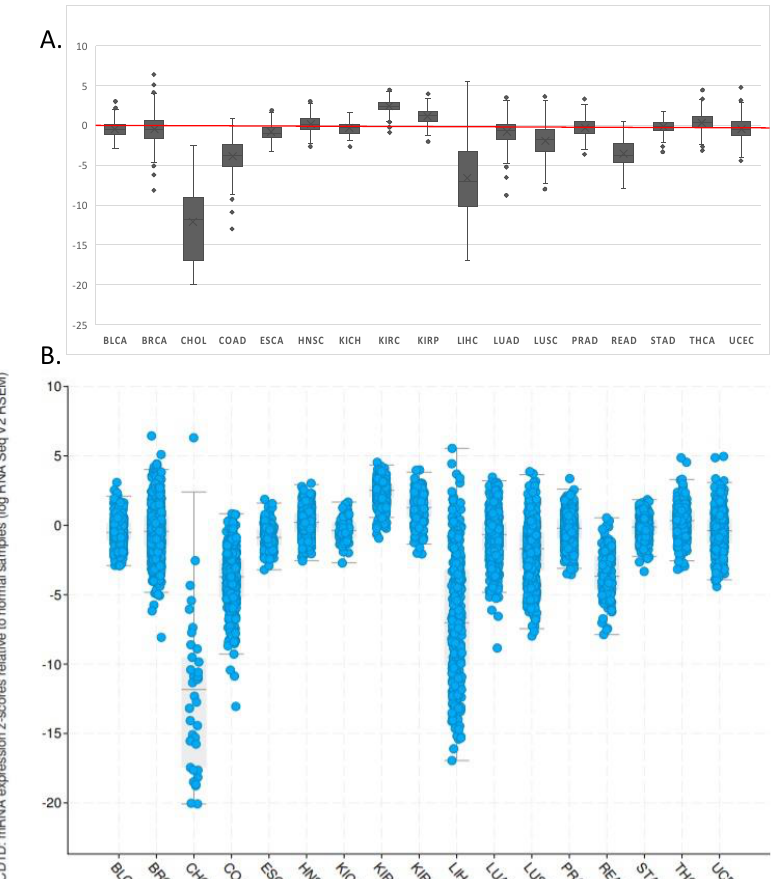
Figure 1. CD1D expression in different cancer types compared to corresponding healthy tissues. NKT cells can recognize and mediate cytolysis, thus CD1d-expression on malignant cells is an area of active investigation. It is thought that higher expression of CD1d leads to in higher tumor cell killing. Thus, several tumors have been shown to downregulate CD1d expression, perhaps in order to escape NKT cell-mediated immunosurveillance, or these data reflect a positive selection pressure for CD1d-low tumor cells. cBioPortal was used to investigate CD1D expression in different cancer types available in the TCGA database [64]. Data shown represents CD1d mRNA expression z scores relative to normal samples. ( A ) Median levels of CD1D is shown and 0 (no change) is indicated by a red line. ( B ) Each patient sample is indicated by a blue circle. BLCA = bladder urothelial carcinoma; BRCA = breast invasive carcinoma; CHOL = cholangiocarcinoma; COAD = colon adenocarcinoma; ESCA = Esophageal carcinoma; HNSC = Head and Neck squamous cell carcinoma; KICH = Kidney chromophobe; KIRC = Kidney clear cell carcinoma; KIRP = Kidney renal papillary cell carcinoma; LIHC = Liver hepatocellular carcinoma; LUAD = lung adenocarcinoma; LUSC = lung squamous cell carcinoma; PRAD = Prostate adenocarcinoma; READ = Rectum adenocarcinoma; STAD = Stomach adenocarcinoma; HCA = Thyroid carcinoma; UCEC = Uterine Corpus Endometrial Carcinoma.